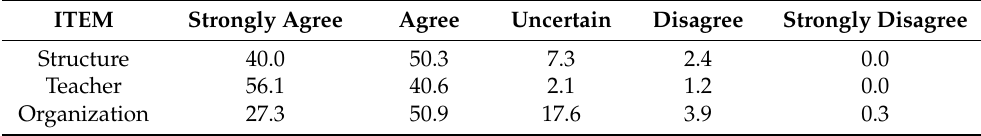
Table 6. Percentages of response for each parent criterion.